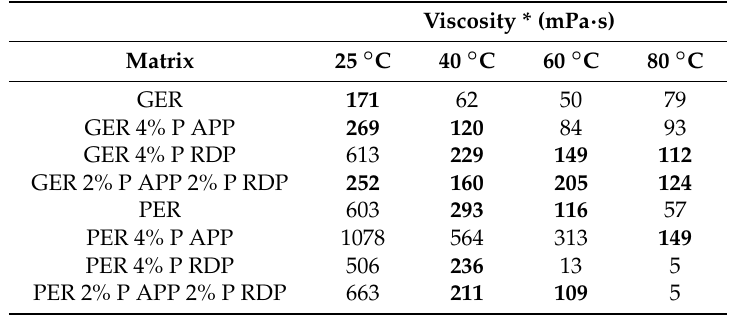
Table 2. Effect of the additive flame retardants on the viscosity of GER and PER matrix samples.